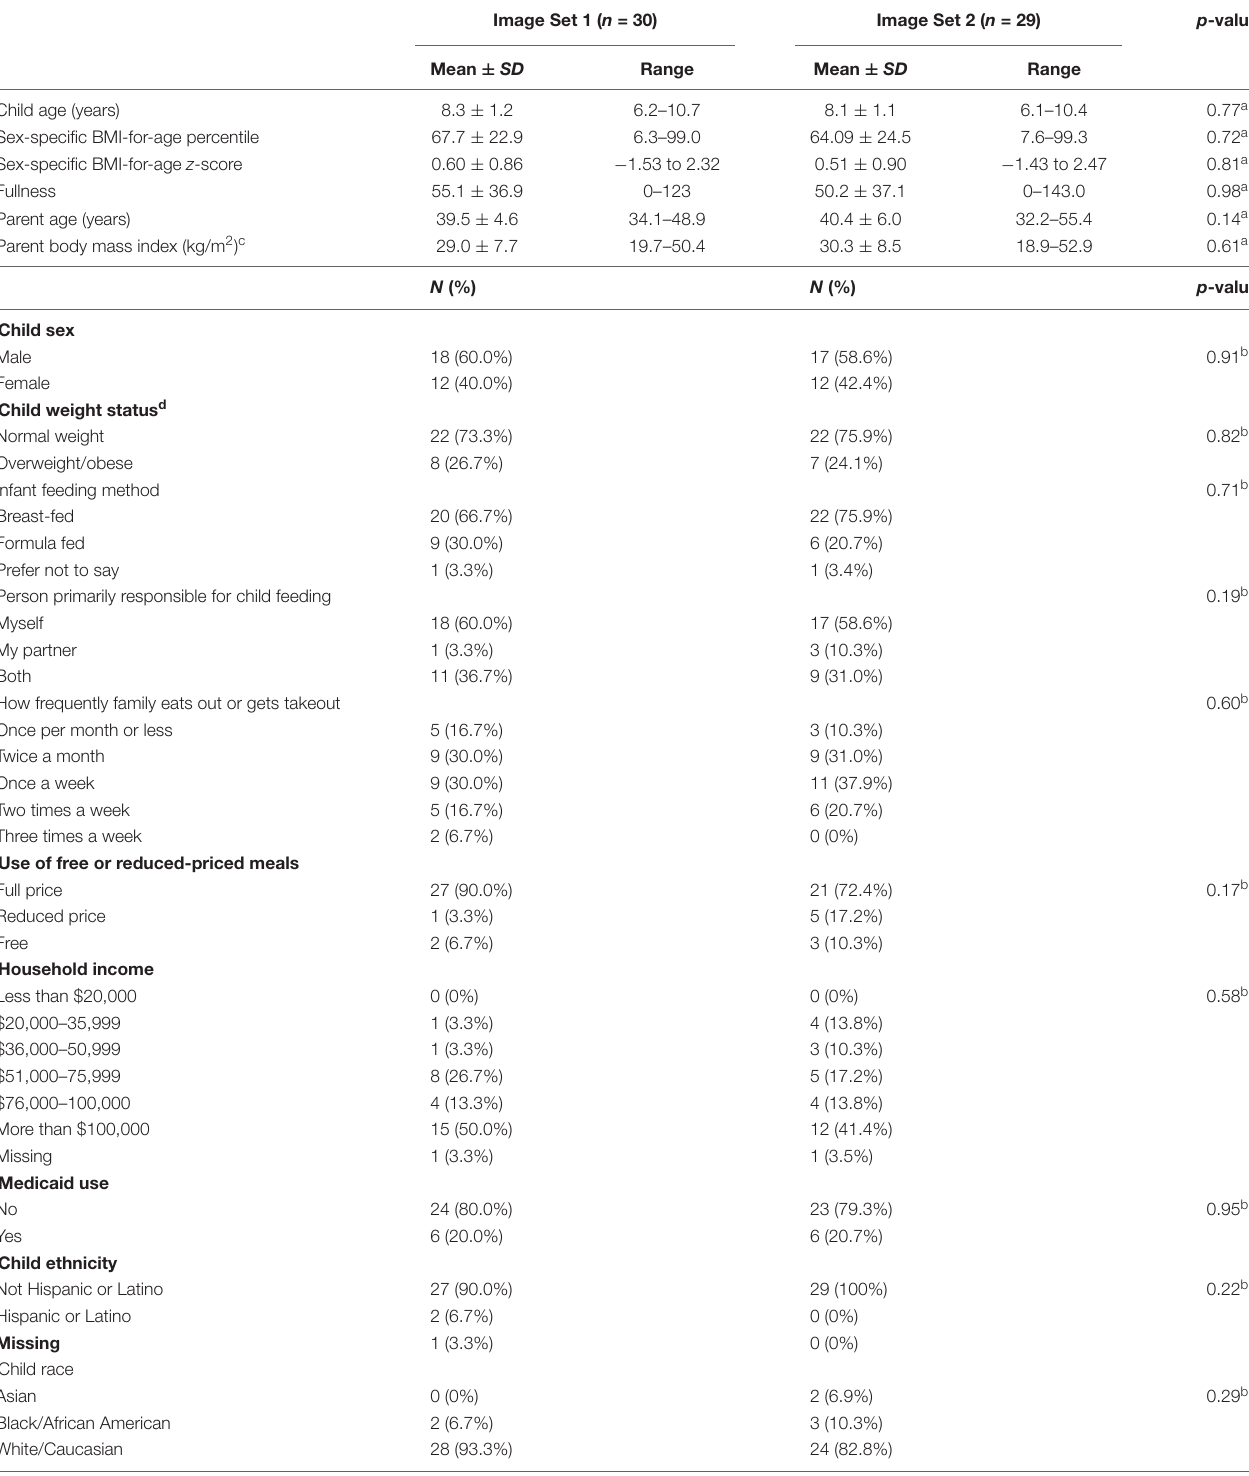
TABLE 4 | Characteristics of 6- to 10-year-old children who rated the emotional valence, excitability, and recognition of a standardized image set developed investigate the cognitive and neurobiological mechanisms of eating